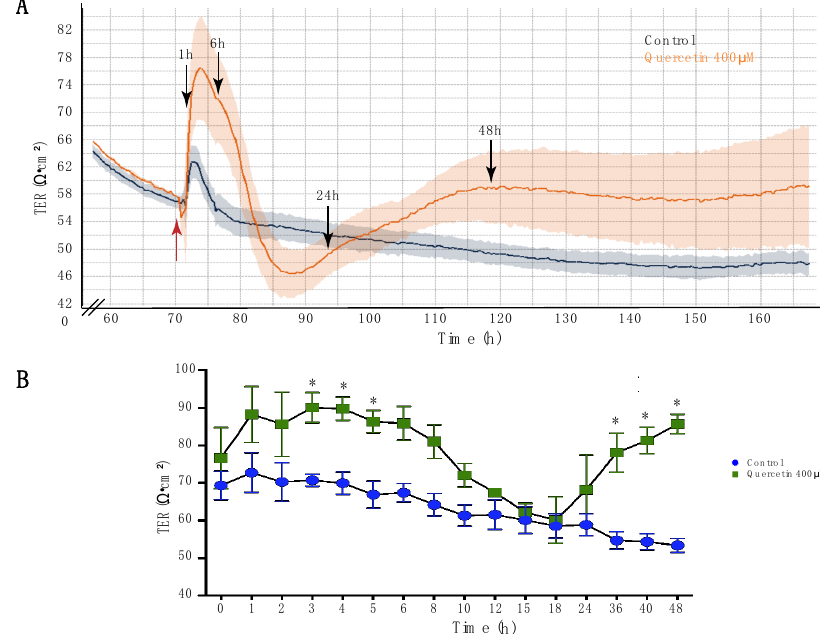
Figure 1. Quercetin caused oscillations in transepithelial resistance (TER) of MDCK II cells. ( A ) Representative plot of TER in control cells (black) and cells treated with 400 µM quercetin (orange) from one biological replicate performed in triplicate. Red arrow indicates when quercetin was added to the culture medium. Black arrows indicate the time points taken for western blot and immunofluorescence analysis. ( B ) TER of control and quercetin-treated cells at different time points after treatment from three independent experiments performed in triplicate. Two-way ANOVA was performed (P int = 0.04; P time < 0.0001; P treat < 0.0001). Mean and SEM are plotted. * Denotes significance, p <